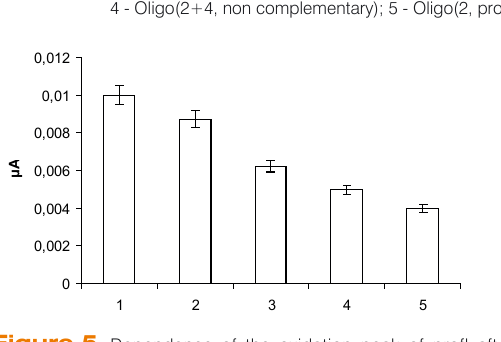
Figure 5. Dependence of the oxidation peak of profl after its interaction with oligos 1 – Profl; 2 - Oligo(2+3,